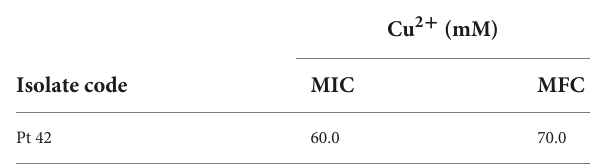
TABLE 2 Minimum inhibitory concentration (MIC) and minimum fungicidal concentration (MFC) determined by Cu 2 + in Plenodomus tracheiphilus